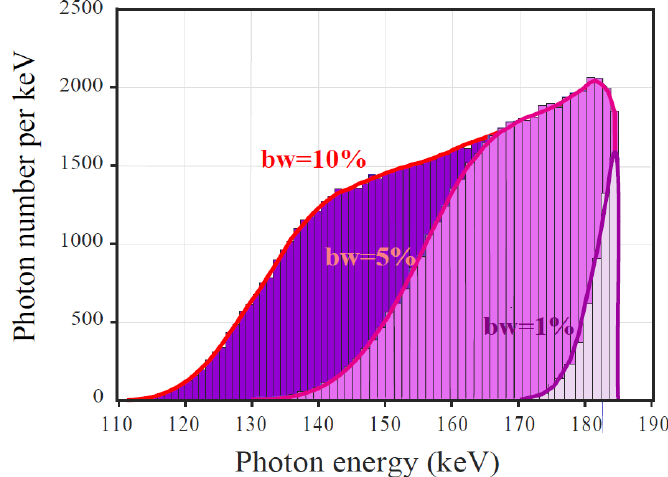
Figure 11. Spectrum of collimated scattered photons for the high energy case E e = 100 MeV. Violet histogram: bw = 10%, θ max = 3.3 mrad; magenta histogram: bw = 5%, θ max = 2.08 mrad; grey histogram: bw = 1%, θ max = 0.6